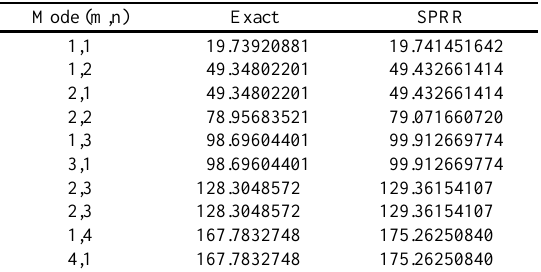
Fig. 7. Eigenvalues of simply supported beam with intermediate spring support (approximate deflection functions, α = 0 . 5 ). (cid:5) Table 3 m/D , Natural frequencies of simply supported plate. Ω = ωa 2 α = 1 , ν = 0 . 3 . SPRR, Rayleigh Ritz method with spline